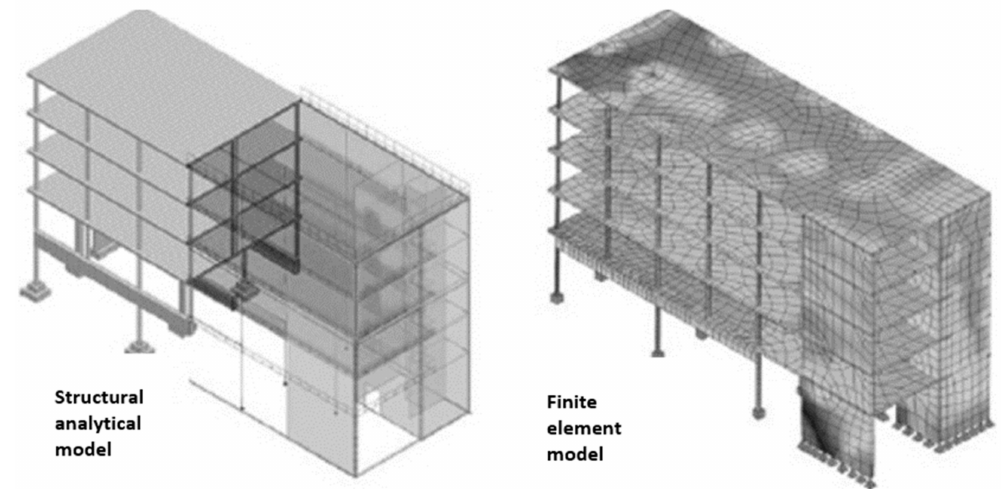
Figure 2. Structural analytical model of an office building and the finite element mesh generated from it